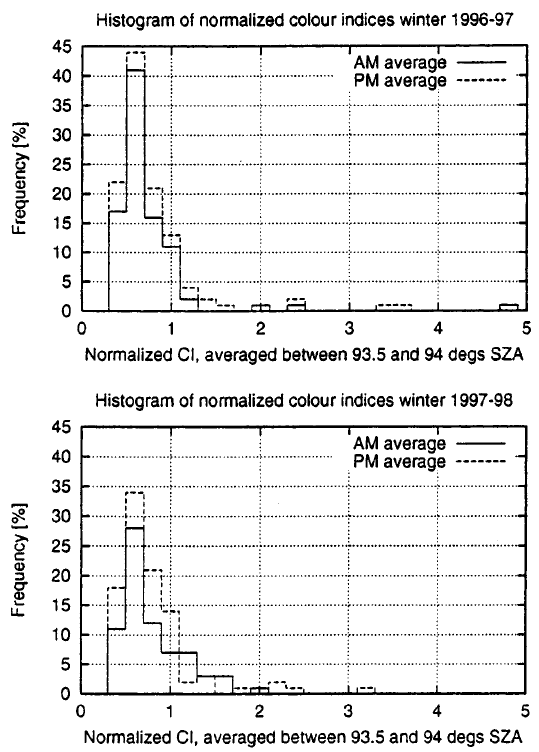
Fig. 5. Histograms of colour index ratios [CI norm (cid:136) CI (cid:133) SZA (cid:134) = CI (cid:133) 90 (cid:14)